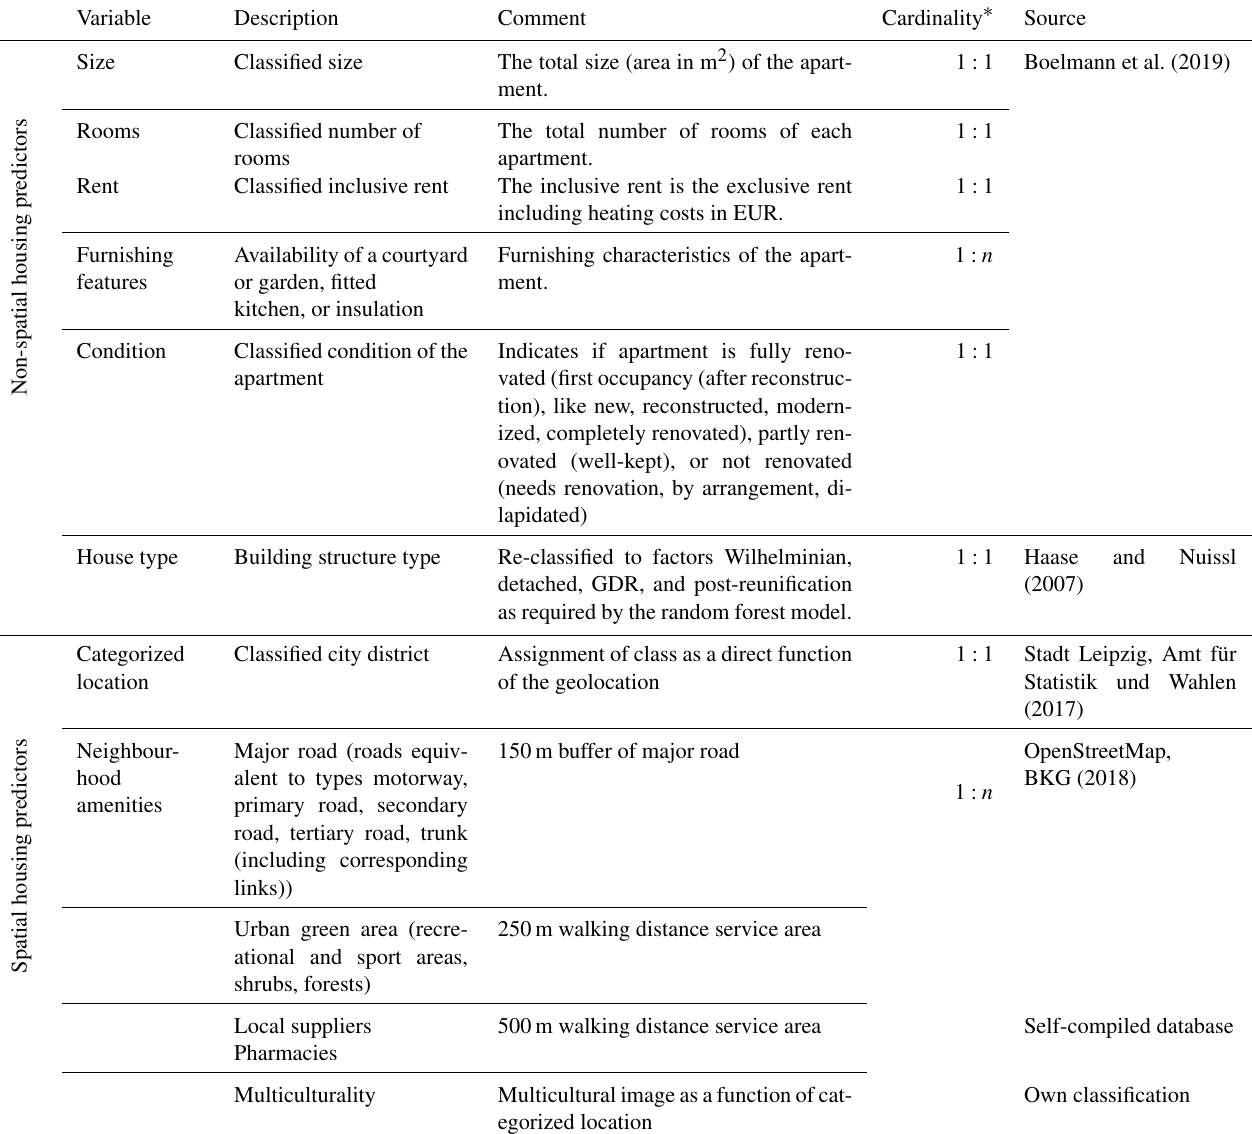
Table 1. Types, variables, description, cardinality, and source of data.